Question: Briefly state, in one sentence, what is plotted here.
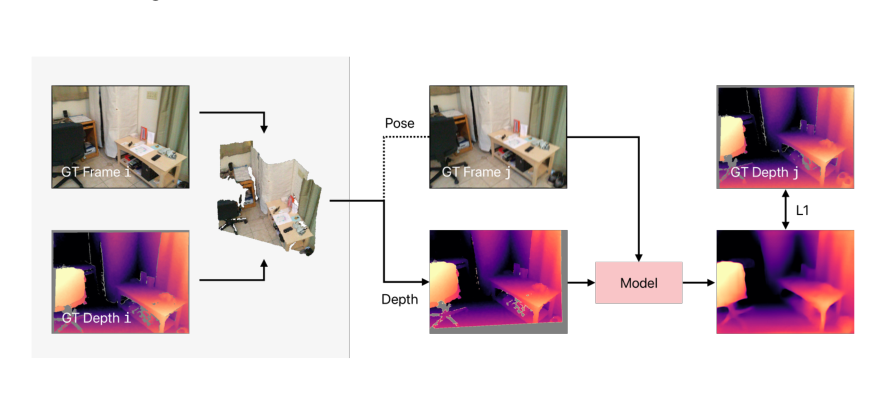
Answer: Overview of our scene consistency evaluation approach. Assume a scene is described by a set of views {v1, v2, . . . } with associated images, depth maps, and camera poses, where the overlap of two views is described by a function ϕ(vi, vj). For a given view pair (vi, vj) with ϕ(vi, vj) ≥τ, we generate a representation, e.g., a point cloud, from the ground-truth (GT) data for vi. Then, we render the representation from the view point of vj. We feed the corresponding ground-truth image and the representation’s depth into the model under consideration to extrapolate the missing depth. Finally, we calculate the mean absolute error between the result and the ground- truth depth for vj, only considering those regions that were extrapolated.